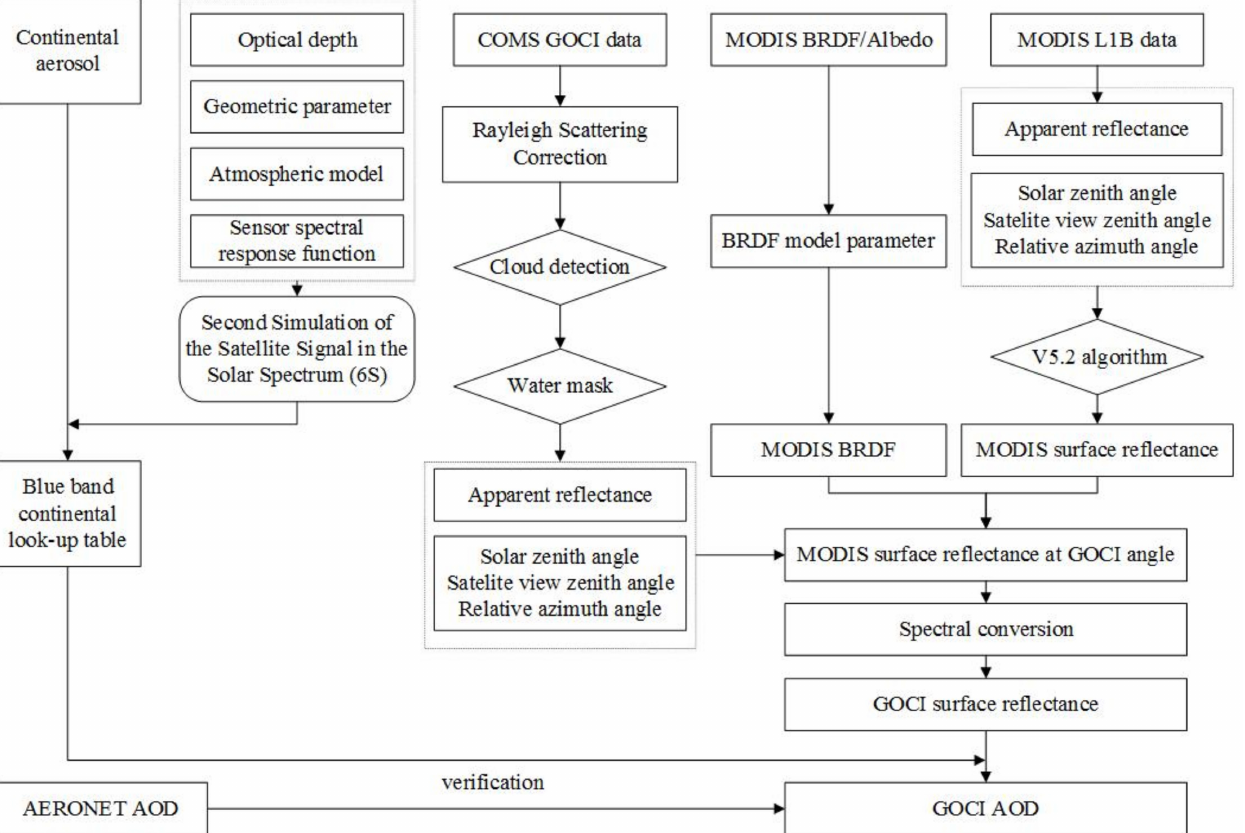
Figure 1. Flow chart of the AOD retrieval algorithm from GOCI